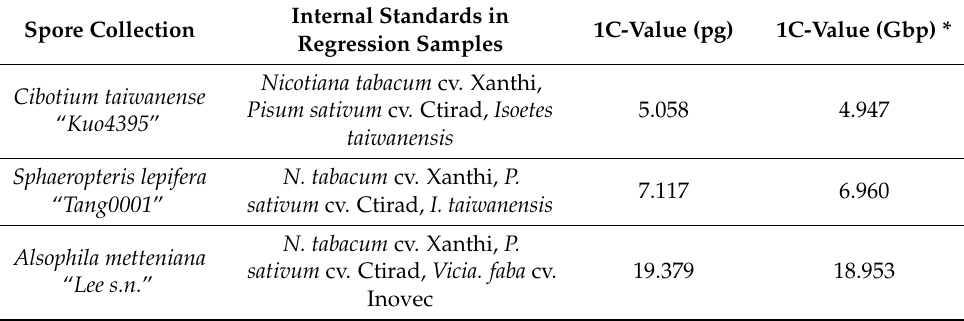
Table 5. Recommended C-values of the three spore collections inferred by linear